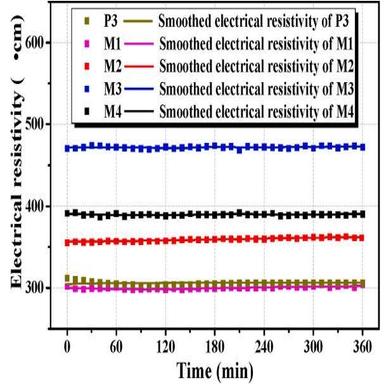
Electrical resistivity of saturated mortar.